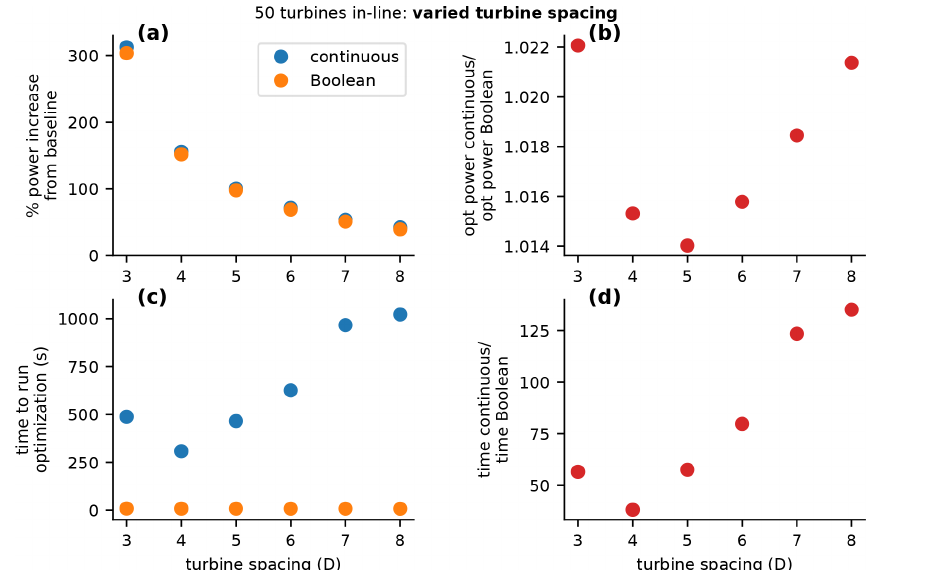
Figure 4. Comparison of a wind plant optimized with a traditional continuous design space compared to our novel Boolean optimization. The results in this figure are for a single row of turbines in-line with the incoming wind. For the purposes of this figure, the number of wind turbines was constant at 50, while each panel shows different metrics as a function of the spacing between wind turbines. (a) The absolute percent increase in power over the nonyawed baseline for the continuous and Boolean optimizations. (b) The ratio of the optimized power with the continuous approach to the optimized power with the Boolean approach. (c) The absolute time required to run each optimization, again for the continuous and Boolean approaches. (d) The ratio of the time required to optimize with the continuous approach to the time required to optimize with the Boolean